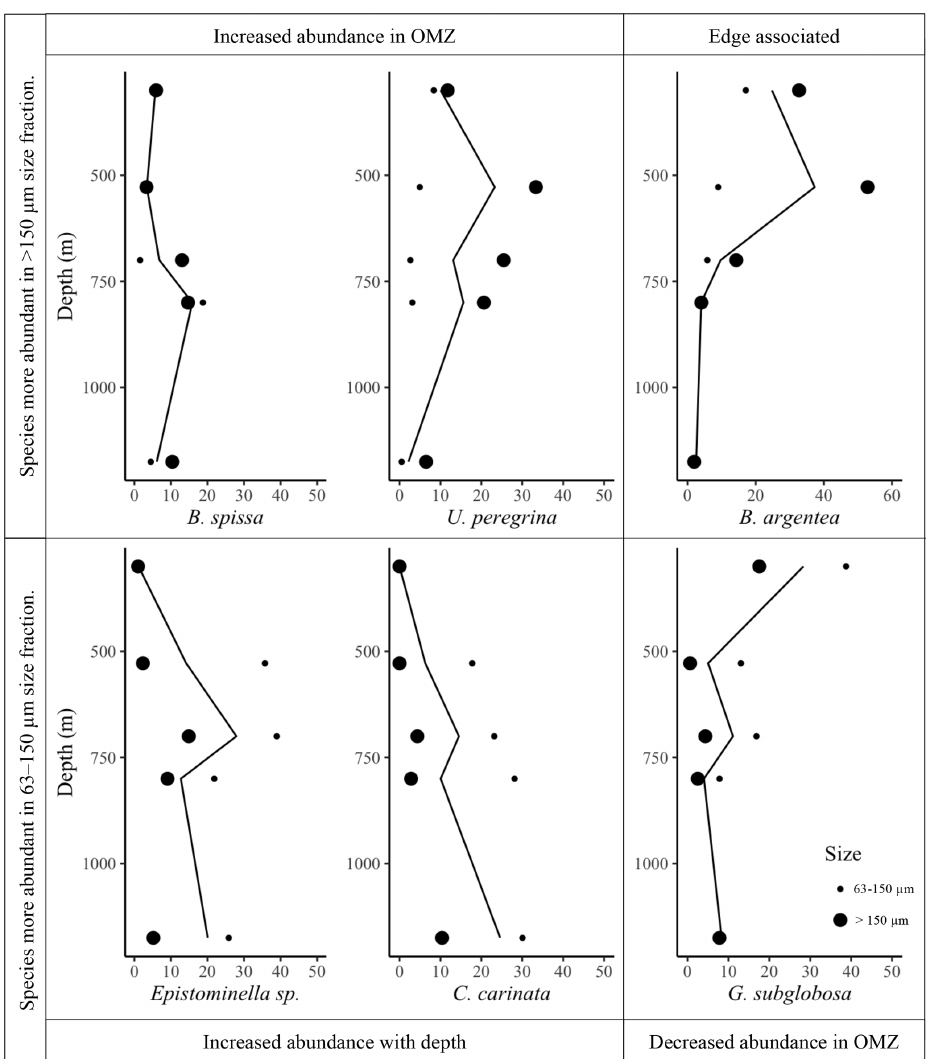
Figure 3. Relative abundance of foraminiferal species (percent of total calcareous taxa) in core top sample (0–2cm) vs. water depth (m). Large black dots are > 150µm size fraction, small black dots are 63–150µm size fraction, and black lines represent trends considering the complete assemblage ( >